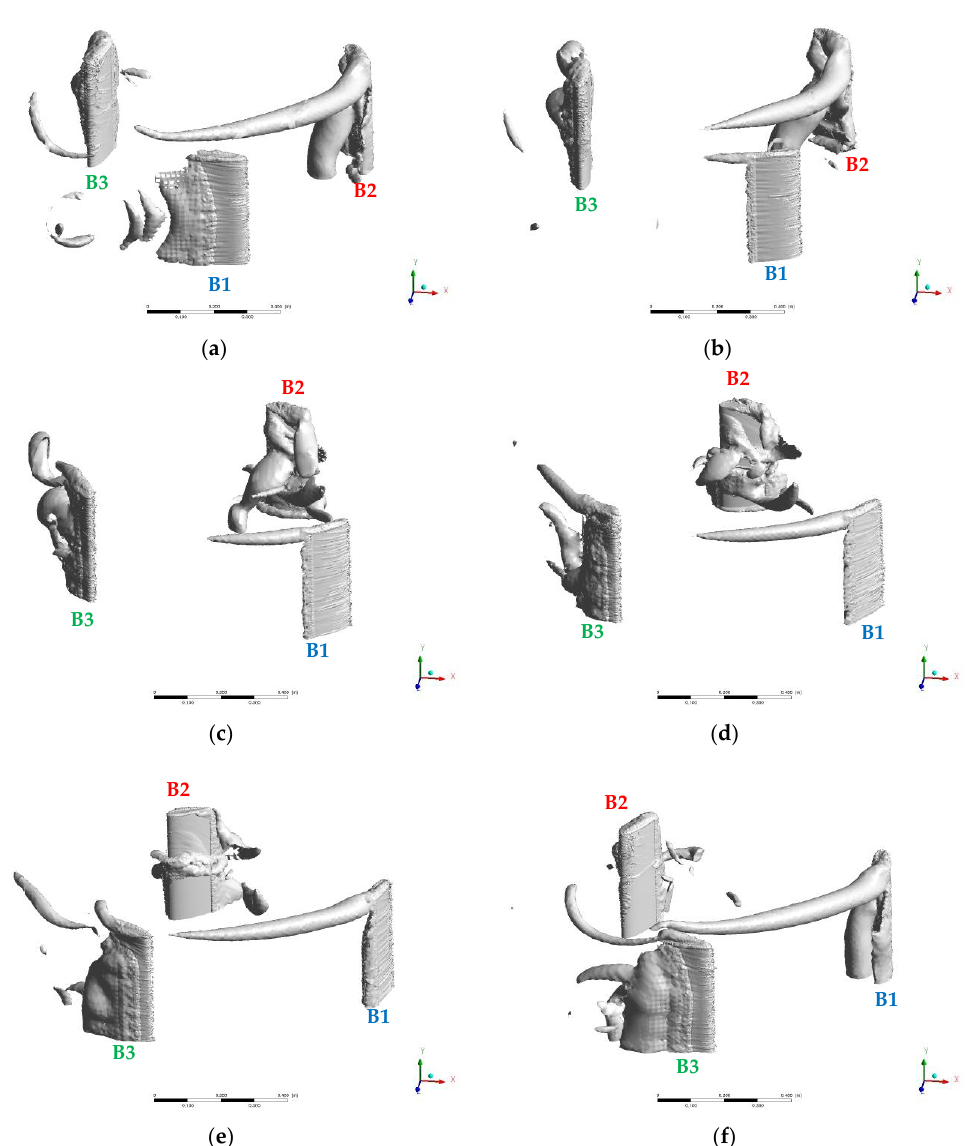
Figure 12. 3D visualization of the evolution of the vorticity iso-surface of 60 Hz for Ω = 40 rpm. Azimuth angle change at each view from ( a – f ) corresponds to 20 o , approximately.